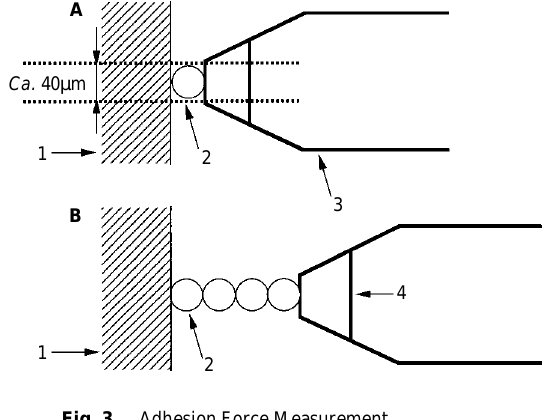
Fig. 3 Adhesion Force Measurement A: Between particle and substrate B: Between particles 1: Substrate 3: Contact needle 2: Particle